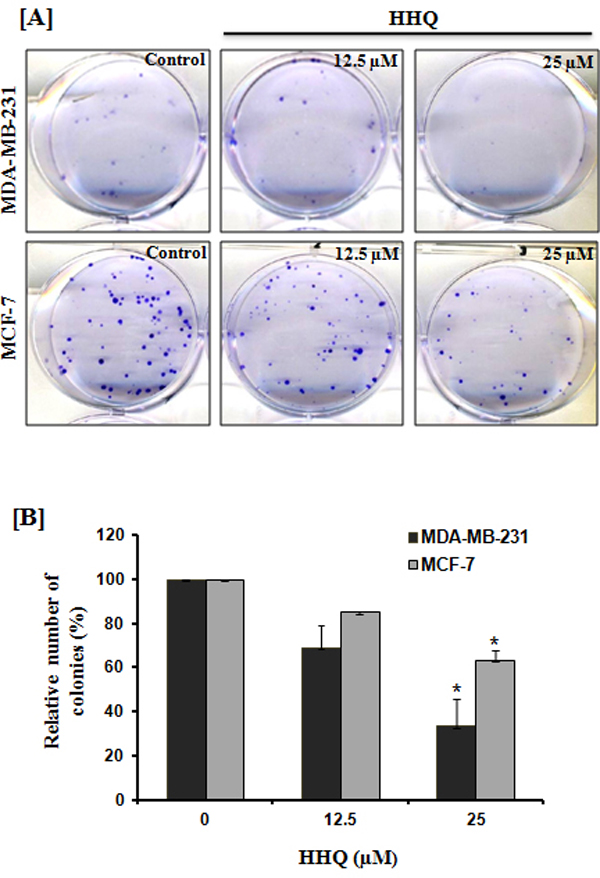
The inhibitory effects of HHQ on colony formation in human breast cancer cells (MDA-MB-231 and MCF-7) as evaluated by clonogenic assay. The breast cancer cells were exposed to 12.5 µM and 25 µM concentration of HHQ for 48 h at 37 °C. [A] Representative plates; [B] graph of the number of colonies formed (the result of three independent experiments, expressed as mean ± SEM). Decrease in number of colonies in HHQ treated groups were statistically significant (*P<0.05).